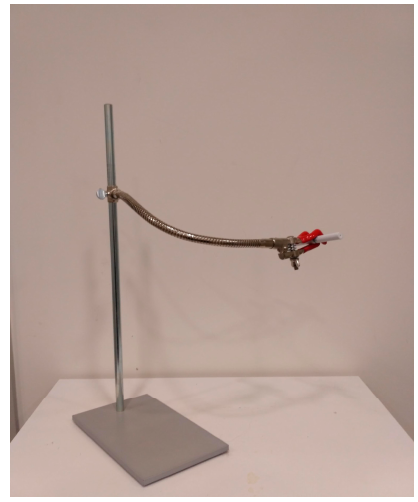
Figure 1. The unipod used in the Unipod condition.